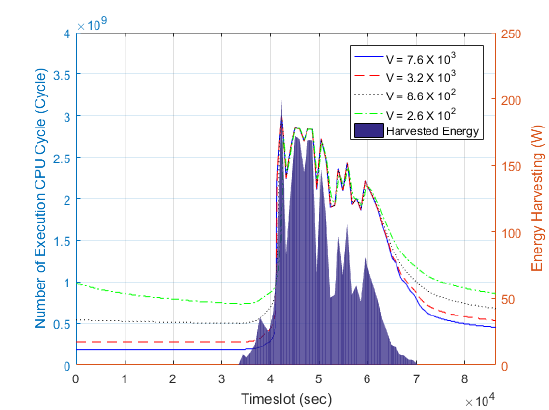
Figure 6. CPU cycles vs. timeslot.